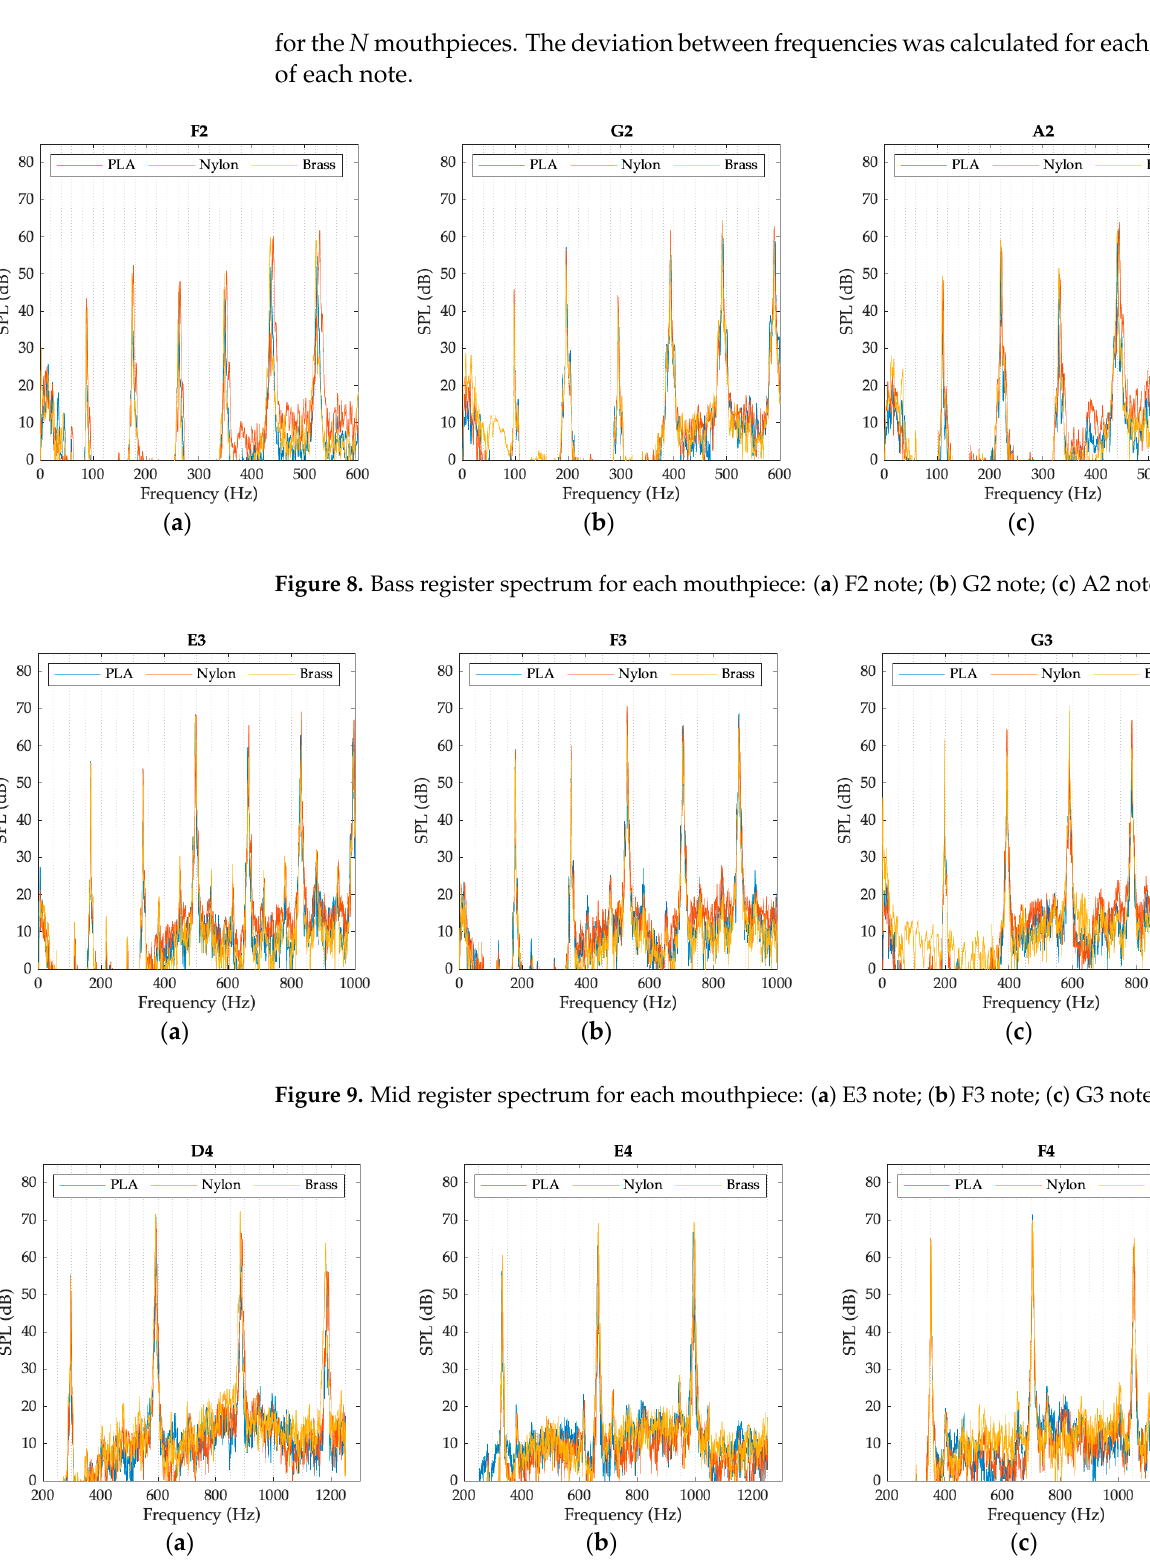
Figure 10. High register spectrum for each mouthpiece: ( a ) D4 note; ( b ) E4 note; ( c ) F4 note. As perceived in the previous analysis, there is practically no difference between the different mouthpieces in the frequencies of the tones and their harmonics. The standard deviation between frequencies has been calculated using Equation (2), with values be- tween 0% and 0.6%.